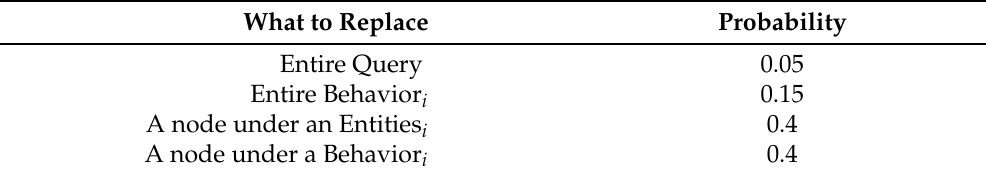
Table 1. The probabilities for selecting nodes for mutation and crossover, grouped by node